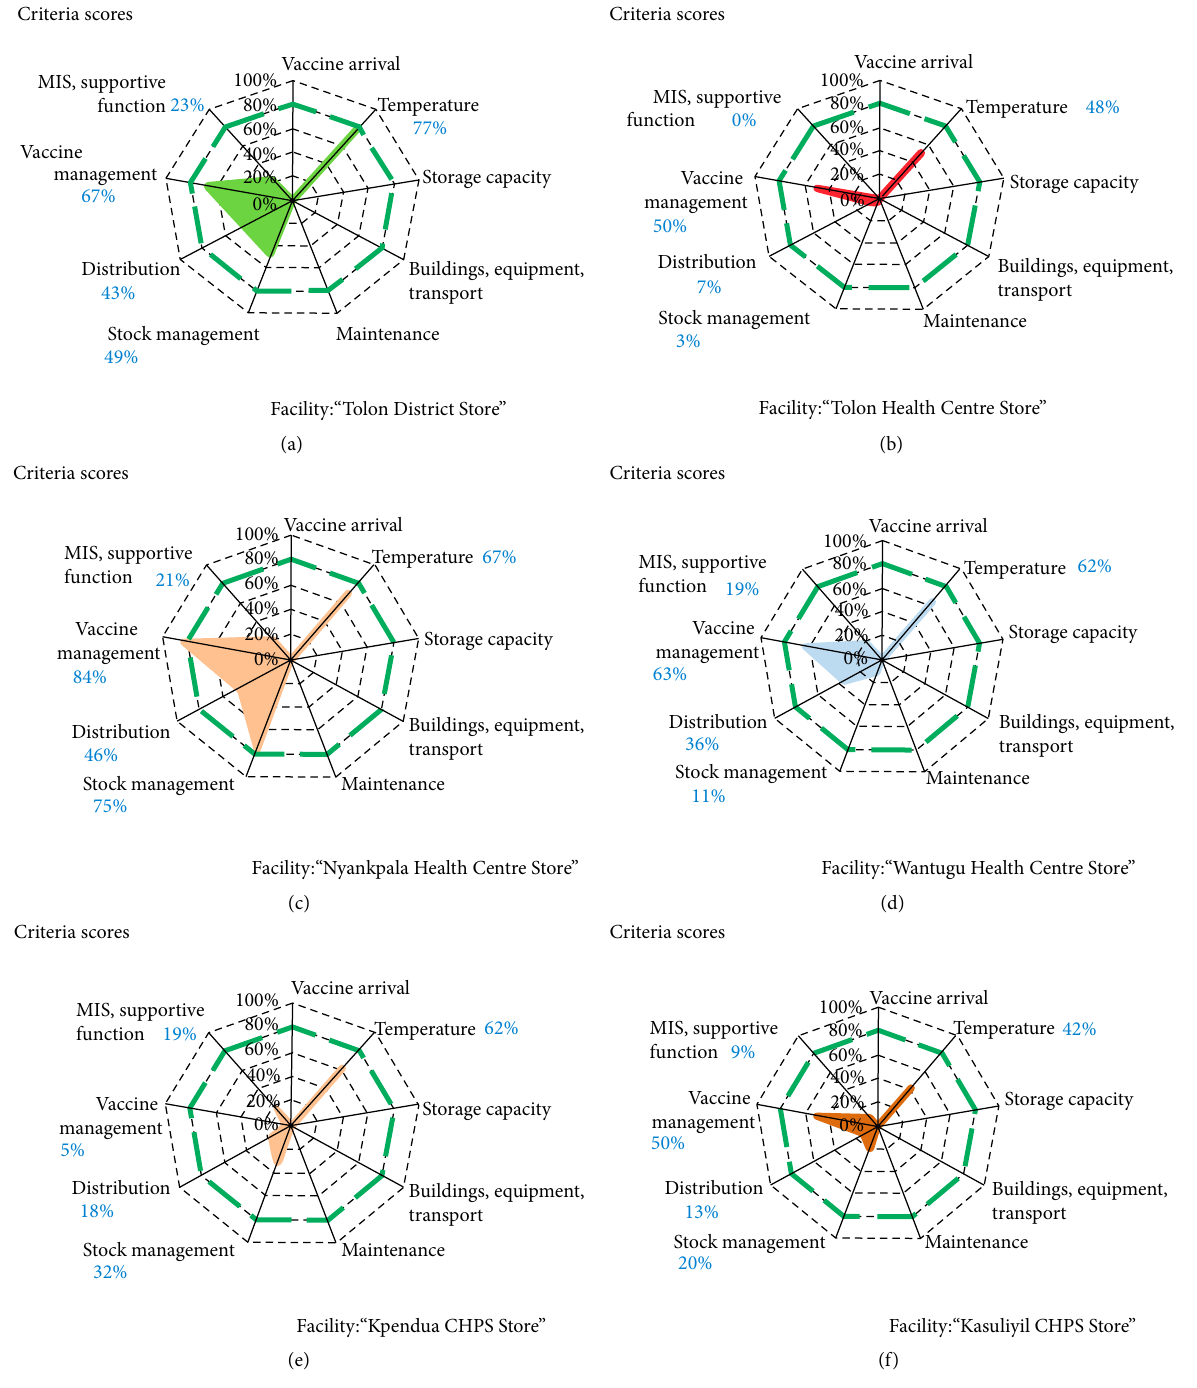
Figure 2: Resulting spider web showing supply chain performance by